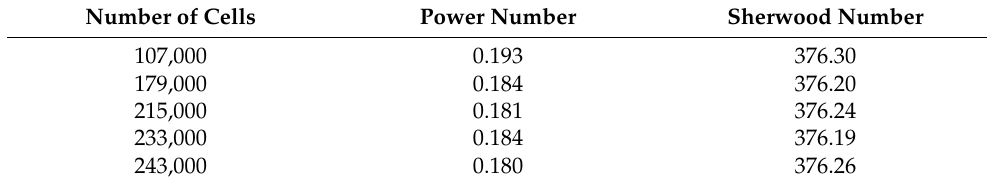
Table 1. Results of the mesh independence